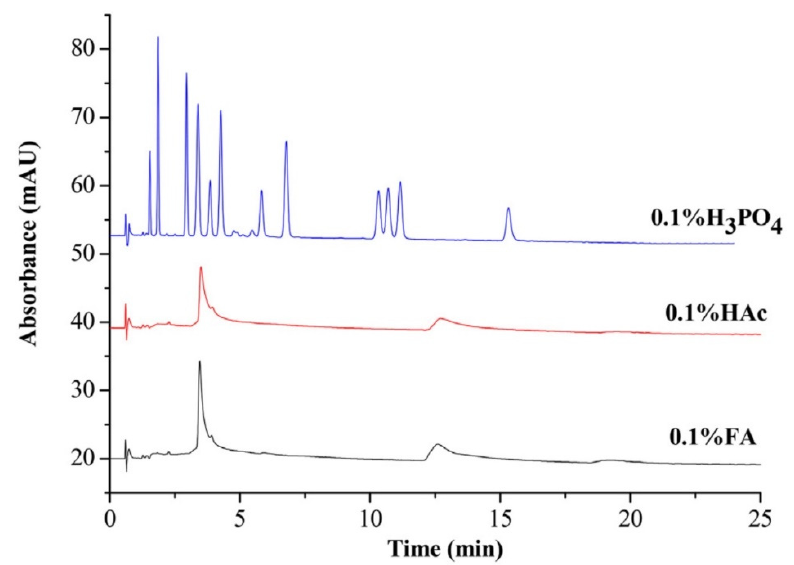
Figure 2. Effect of the addition of an acidic additive to the mobile phase on the separation of flavonoids. Column: ZORBAX RX-SIL column (150 mm × 4.6 mm, 5 µ m); mobile phase: supercritical carbon dioxide (scCO 2 ) and MeOH containing 0.1% formic acid (FA), 0.1% acetic acid (HAc), or 0.1% phosphoric acid (H 3 PO 4 ). Adapted from [61] with permission. Copyright 2017, Elsevier.